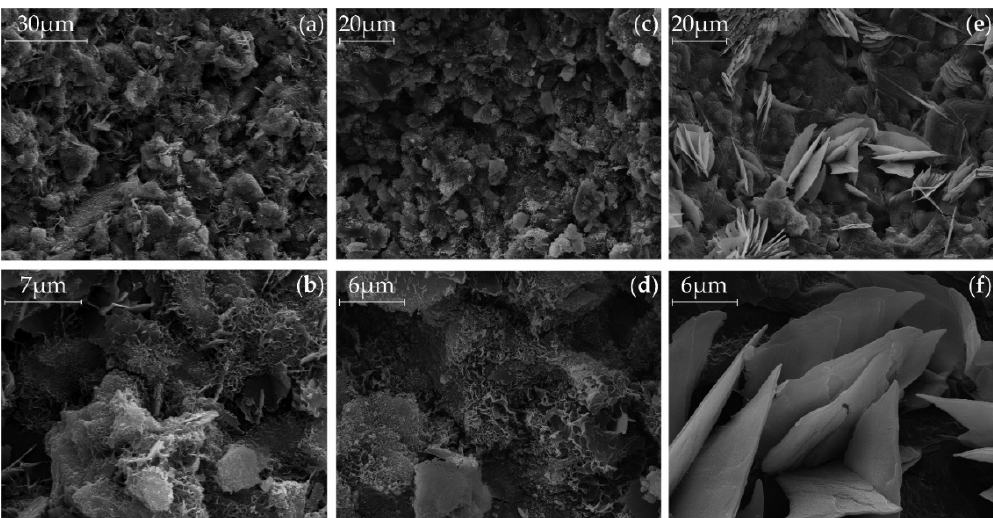
Figure 6. SEM pictures with different magnifications after a hydration period of 28 days, ( a ) and ( b ) of the reference of Ac1, ( c ) and ( d ) of the surface, ( e ) and ( f ) of pore of the reactivated mixtures with Ac1 after 14 days of retardation with 1%R.